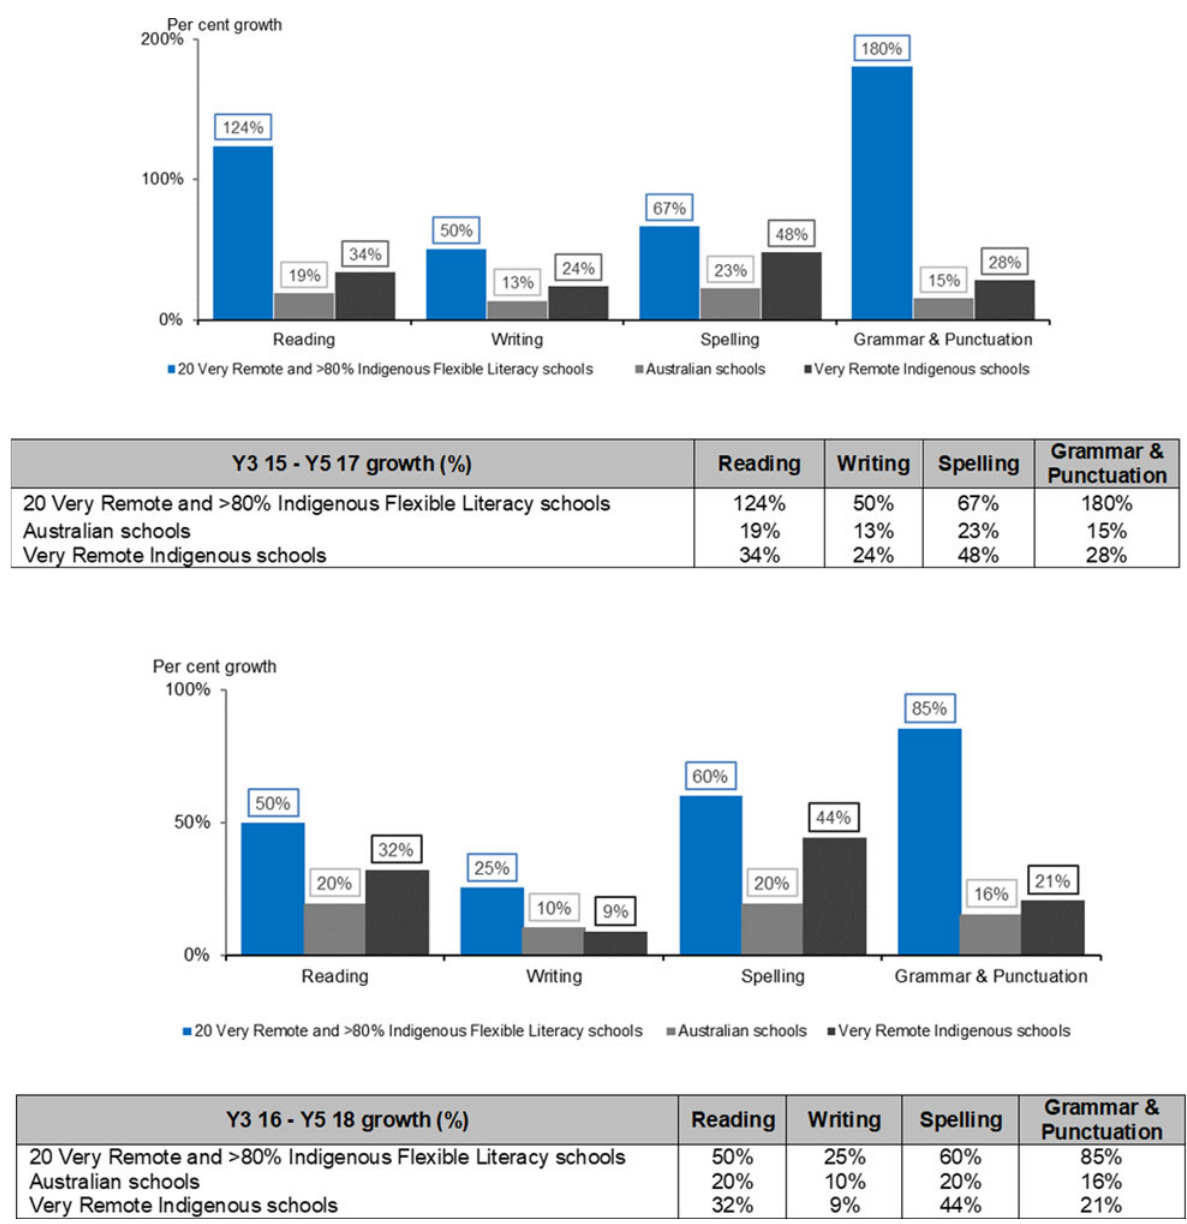
Fig. 2. NAPLAN literacy growth made by the 20 schools participating in the Flexible Literacy program compared to Australian and Very Remote Indigenous schools (Year 3 2015 – Year 5 2017). NAPLAN literacy growth made by the 20 schools participating in the Flexible Literacy program compared to Australian and Very Remote Indigenous schools (Year 3 2016 – Year 5